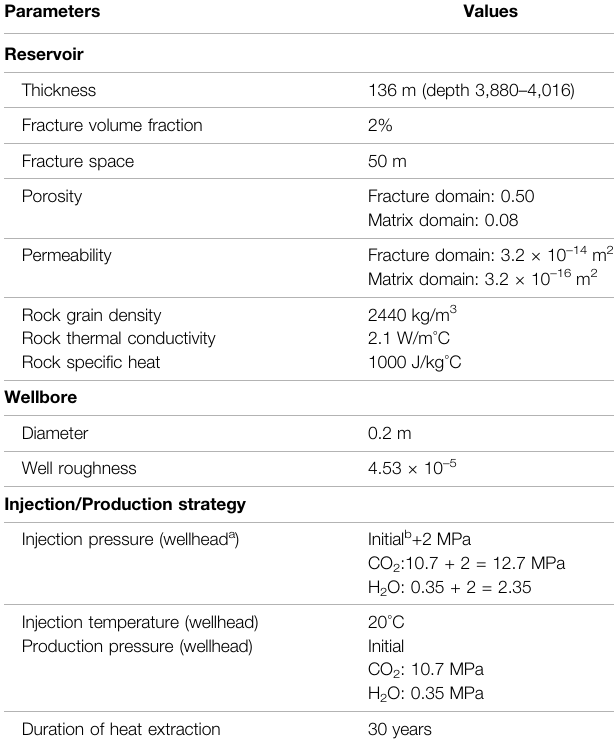
TABLE 2 | Parameters for the fi ve-spot heat extraction problem in enhanced geothermal